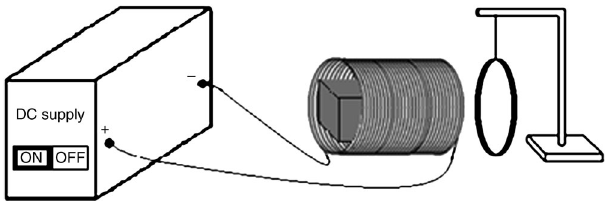
FIG. 6. Experiment 6: demonstrating Lenz ’ s law. An aluminum ring was suspended from a string and put parallel to the large coil with an iron core, an electromagnet. The dc supply was turned on, and after some time,